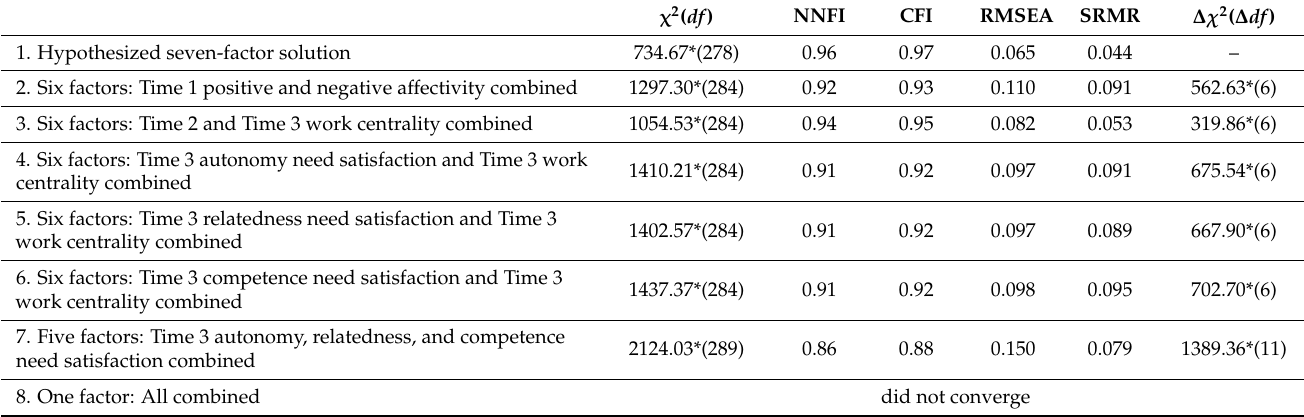
Table 1. Confirmatory Factor Analysis Results: Fit Indices.